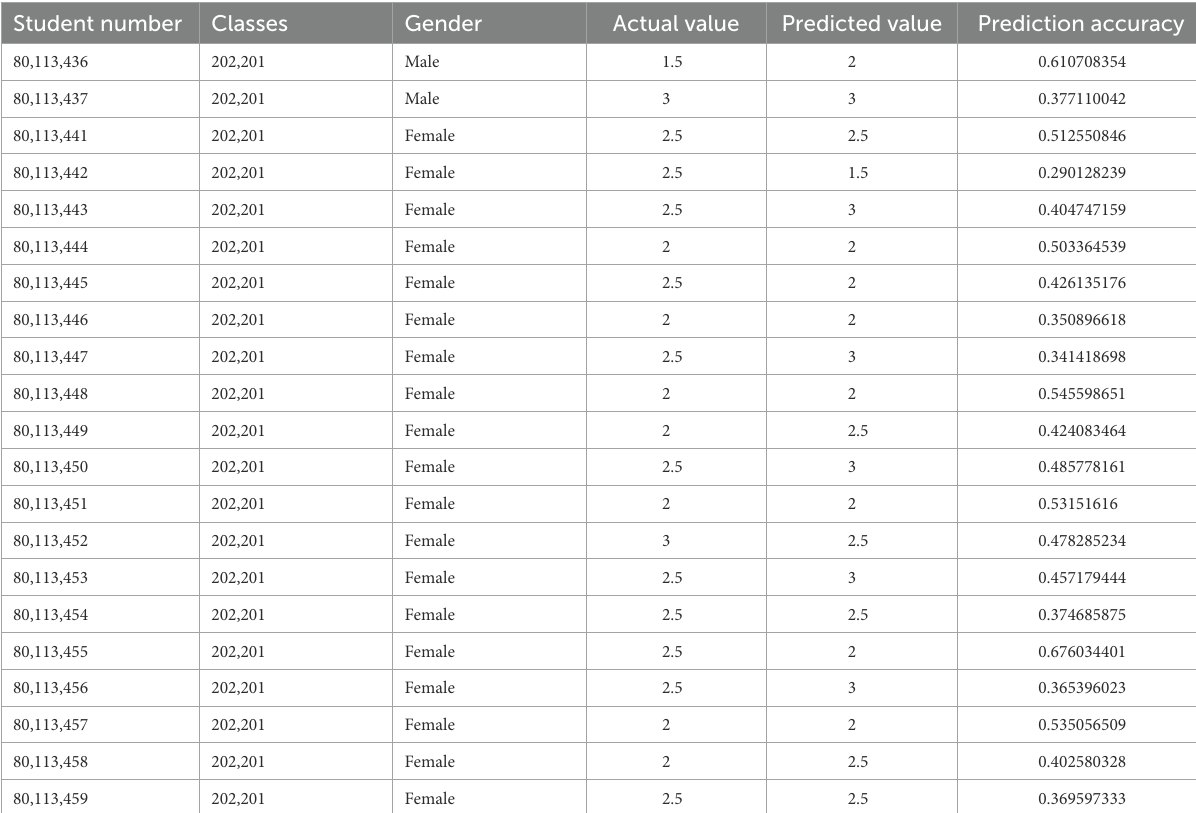
TABLE 3 Some results when the prediction table is normal_2022 (Sophomore